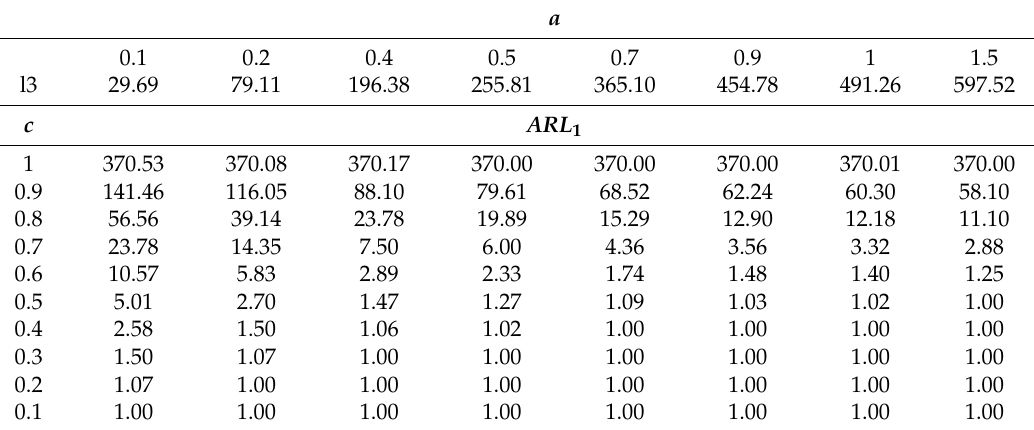
Table 6. The values of ARLs when r 0 = 370, β = 1.5, and µ 0 = 100.